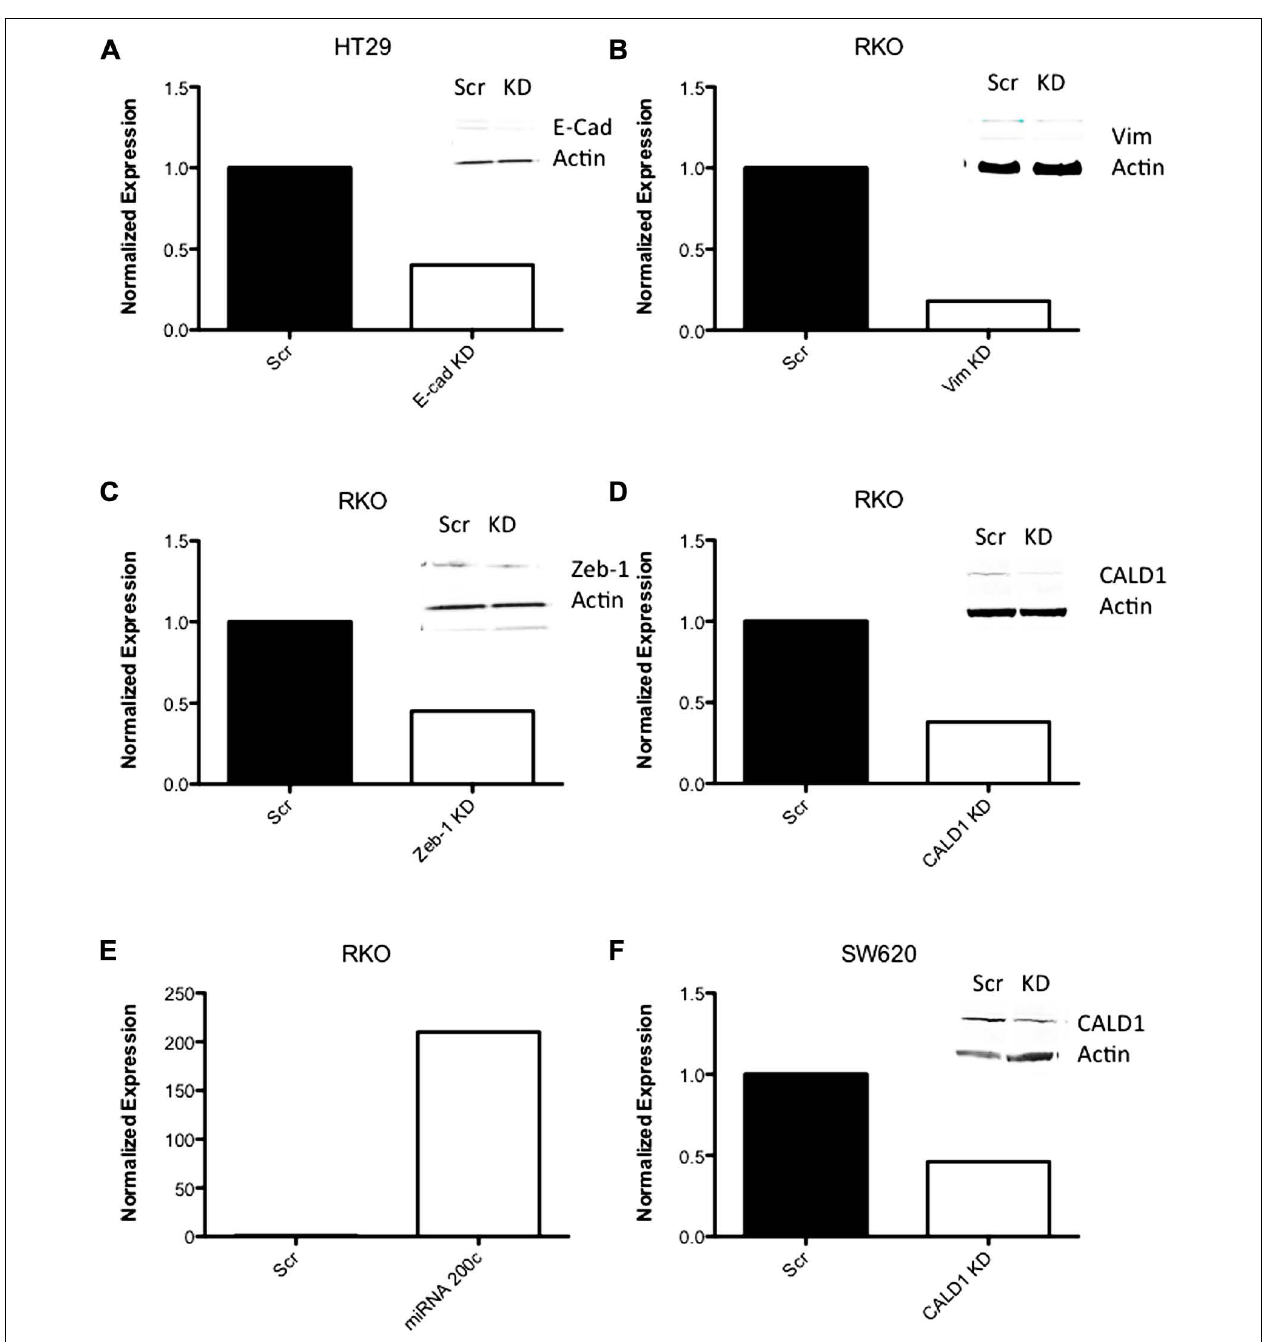
FIGURE 9 | RT-PCR data of shRNA knockdown and expression. (A–D, F) RT-PCR data of CRC cell lines following transfection with shRNA to EMT-related genes. (E) RT-PCR of miRNA 200c following transfection with an expression vector containing miRNA 200c.